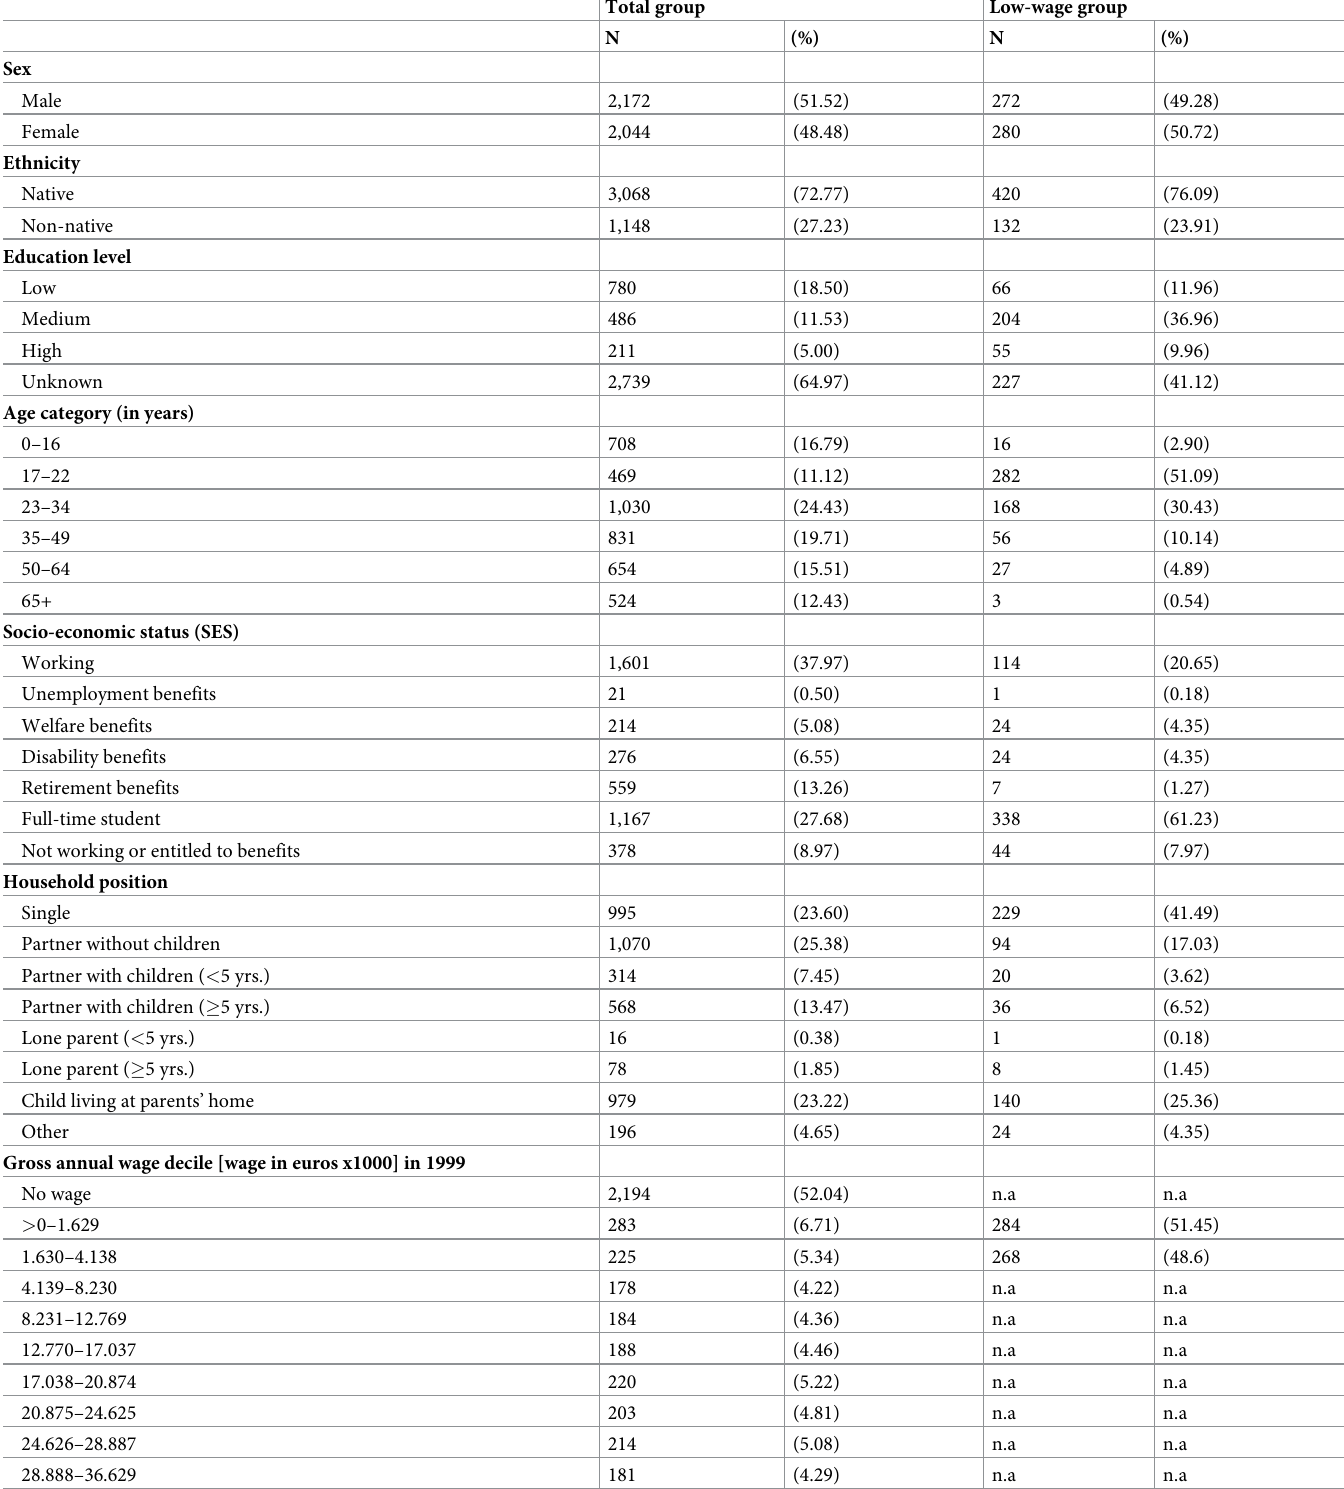
Table 1. Demographics of the total group of affected residents (N = 4,216) and affected low-wage group (N = 552) on May 13,